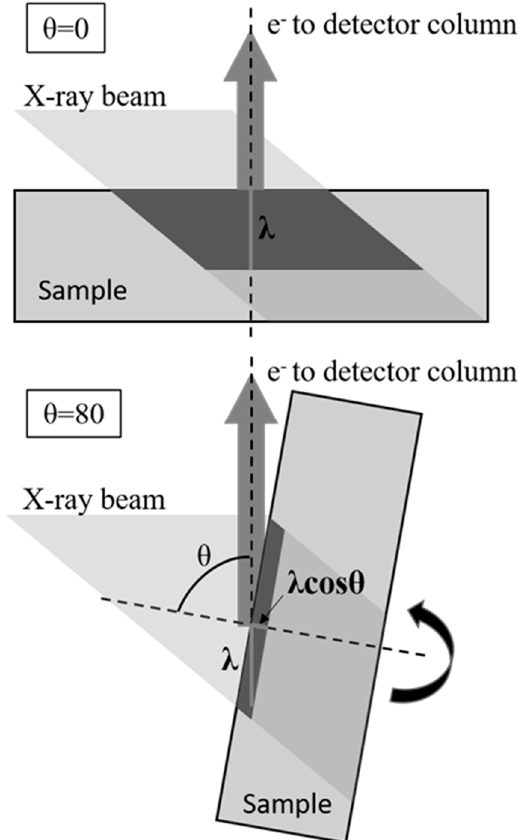
Figure 1. ARXPS set-up scheme. The angle between the X-ray beam and the detection column is constant. Polar angle θ is the angle between the sample normal and detector column and is selected by tilting the sample stage. An electron that can escape from the sample by traveling a distance λ in the detector column direction can come from the same depth λ as the maximum for θ = 0°. For different θ values, the same electron will escape from a reduced maximum depth equal to λ cos θ . The region from which electrons can escape by travelling a distance λ to the detection column is dark shaded.